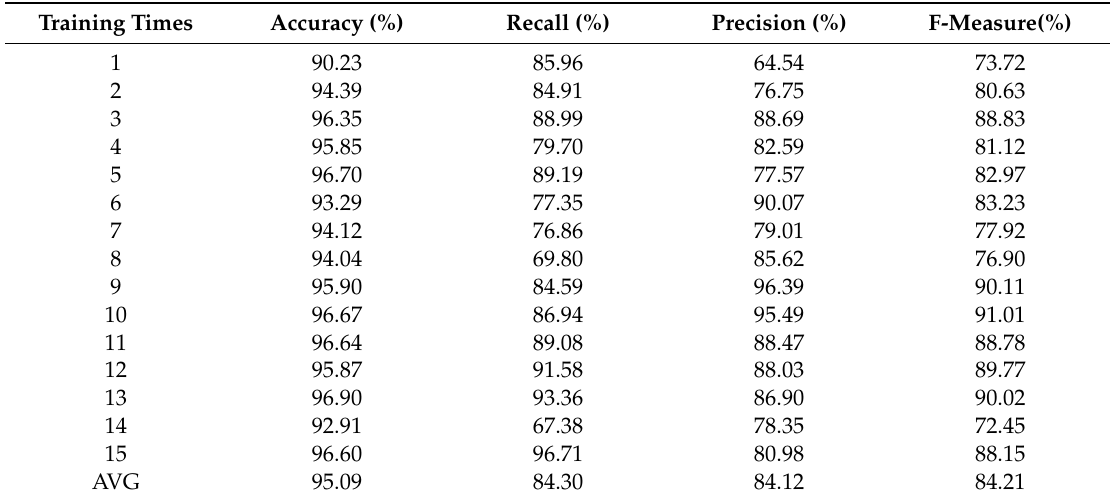
Table 14. Pixel-level classification performance indicators of OSCNet.